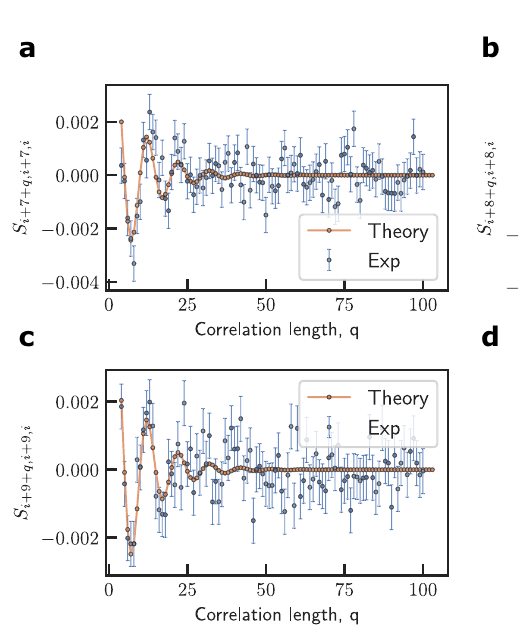
Fig.4|Quantumcorrelationofasinglenuclearspin.a – c showthethirdmoment S i , i + p , i + p + q as a function of p for q =7, 8, and 9 in turn. The purple symbols are experimental data. The orange curves are theoretical results with the fi tting parameter r beingtheratiooftheamplitudeofthethirdmomenttotheamplitude squaredofthesecondmoment(notshown). t c isthesameasinFig.3a. d Thefactor